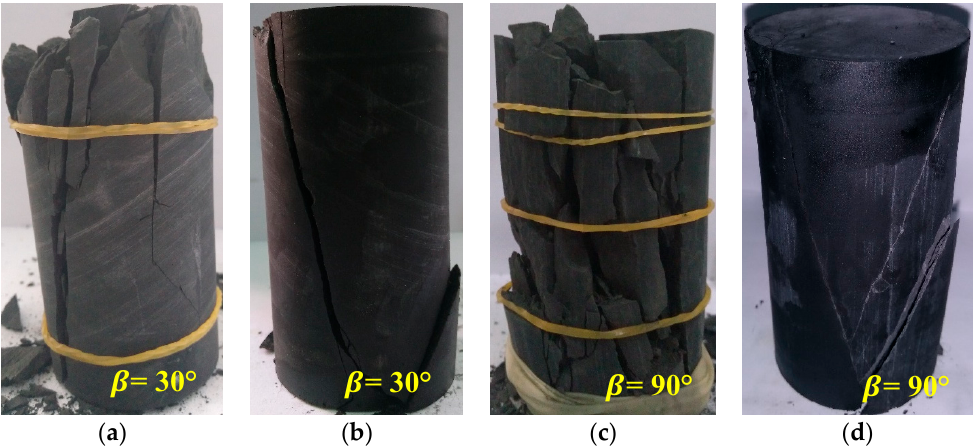
Figure 9. Different failure patterns of Shale-5 samples with inclination angle β = 30 ◦ under the confinements of ( a ) σ 3 = 0 MPa; ( b ) σ 3 = 60 MPa and β = 90 ◦ under the confinements of ( c ) σ 3 = 0 MPa; ( d ) σ 3 = 60 MPa.